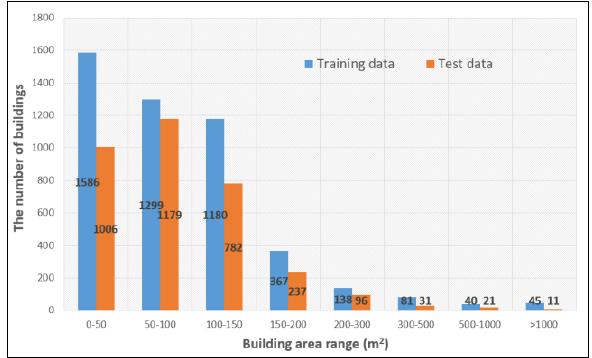
Figure 2 . Building area histogram for the training and test data.